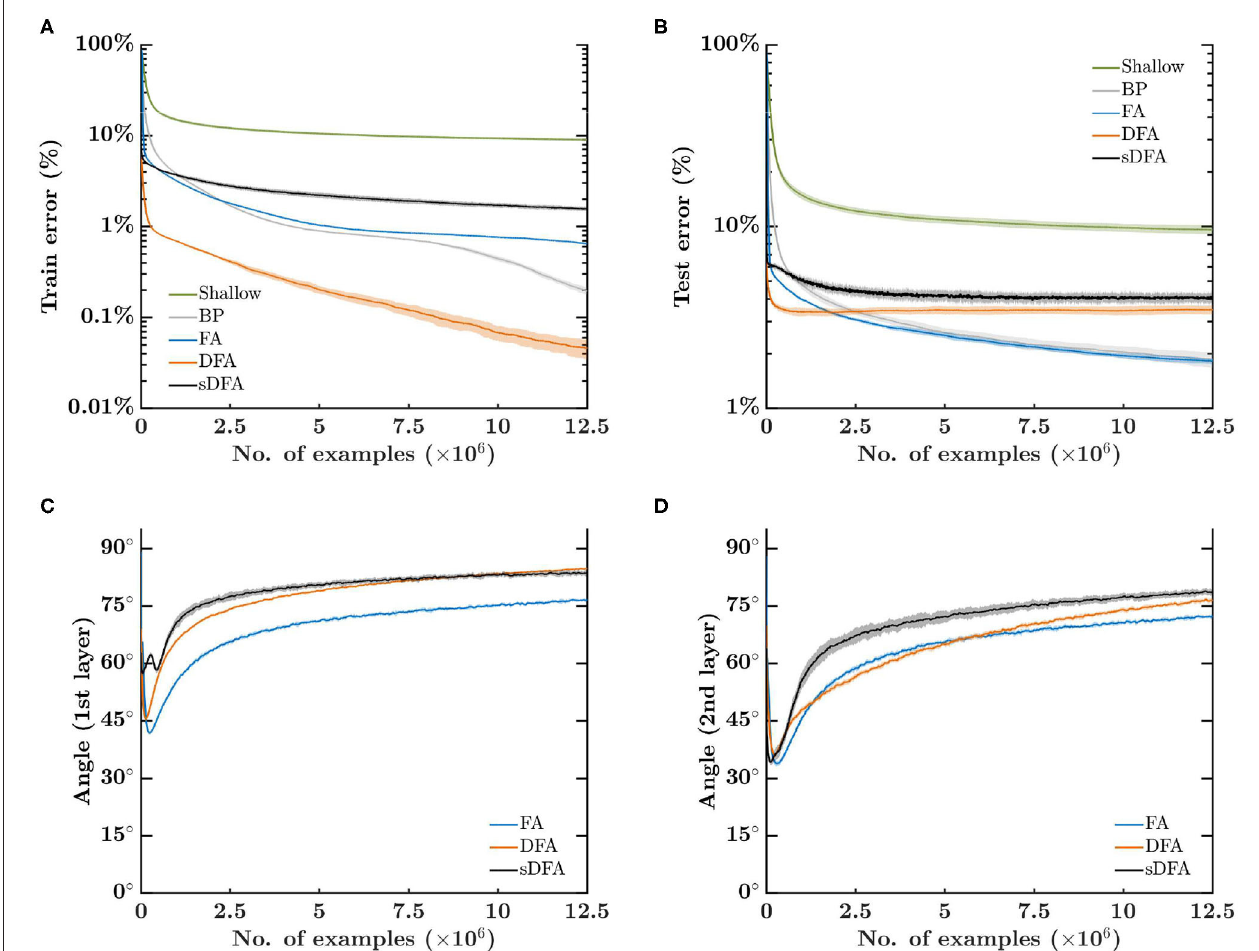
FIGURE 3 | Error-sign-based direct feedback alignment (sDFA) provides useful modulatory signals in classification tasks. A 256-500-500-10 network with tanh hidden units and sigmoid output units is trained to classify a synthetic dataset of 16 × 16-pixel images into 10 classes with five training algorithms: shallow learning, BP, FA, DFA and sDFA. With this simple setup, BP and FA suffer from the vanishing gradients problem, which would be alleviated by using ReLU-based networks with batch normalization. The scope of the figure is to highlight that sDFA provides useful modulatory signals for classification tasks, without any additional technique. The update directions of the sDFA algorithm are within 90 ◦ of the backpropagation updates and are comparable to other feedback-alignment-based algorithms. The train and test losses and the alignment angles are monitored every 2.5k samples, error bars are one standard deviation over 10 runs. Angles have been smoothed by an exponentially-weighted moving average filter with a momentum coefficient of 0.95. (A) Error on the 25k-example training set, reaching on average 0.19% for BP, 0.64% for FA, 0.05% for DFA, 1.54% for sDFA and 8.95% for shallow learning after 500 epochs. (B) Error on the test set, reaching on average 1.85% for BP, 1.81% for FA, 3.48% for DFA, 4.07% for sDFA and 9.57% for shallow learning after 500 epochs. (C) Angle between the modulatory signals δ z k prescribed by BP and by feedback-alignment-based algorithms in the first hidden layer. (D) Angle between the modulatory signals δ z k prescribed by BP and by feedback-alignment-based algorithms in the second hidden